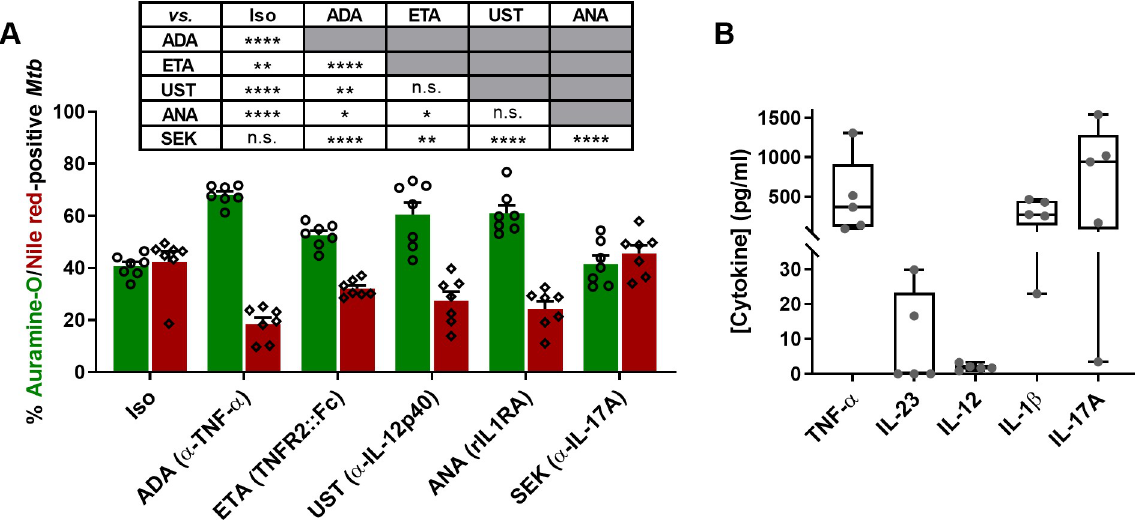
Fig 2. Human, in-vitro granulomas corroborate risk of LTBI reactivation linked to treatment with TNF- α -targeting biologics. (A) Percentages of auramine-O- (green) and Nile red-positive (red) Mtb quantified by fluorescence microscopy (mean ± SEM from 7 independent donors) following 4 days of exposure with an isotype control (Iso), adalimumab (ADA), etanercept (ETA), ustekinumab (UST), anakinra (ANA) or secukinumab (SEK). Statistical analysis was performed using a generalized linear mixed-effects model; n.s., not significant; � , p < 0.05; �� , p < 0.01; ���� , p < 0.0001. (B) Cytokine levels measured in supernatants of untreated in-vitro granulomas 8 days post-infection (median with interquartile ranges, minimum and maximum values for 5 independent donors).